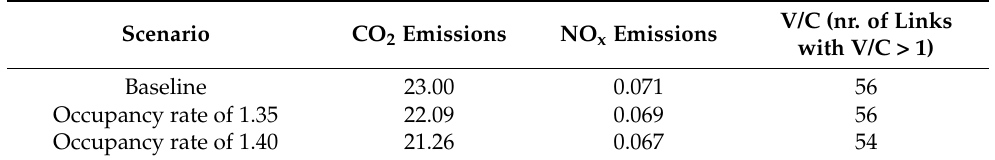
Table 5. Results obtained for scenario